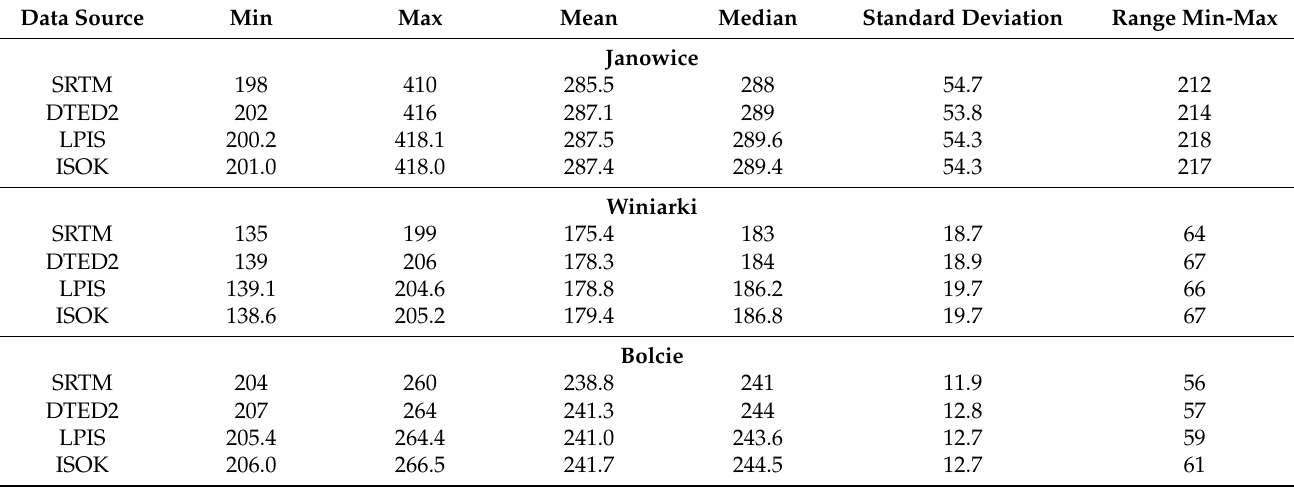
Table 3. Summary of the basic statistics characterising the elevations for all the DTM sources in the 3 research areas. Data Source